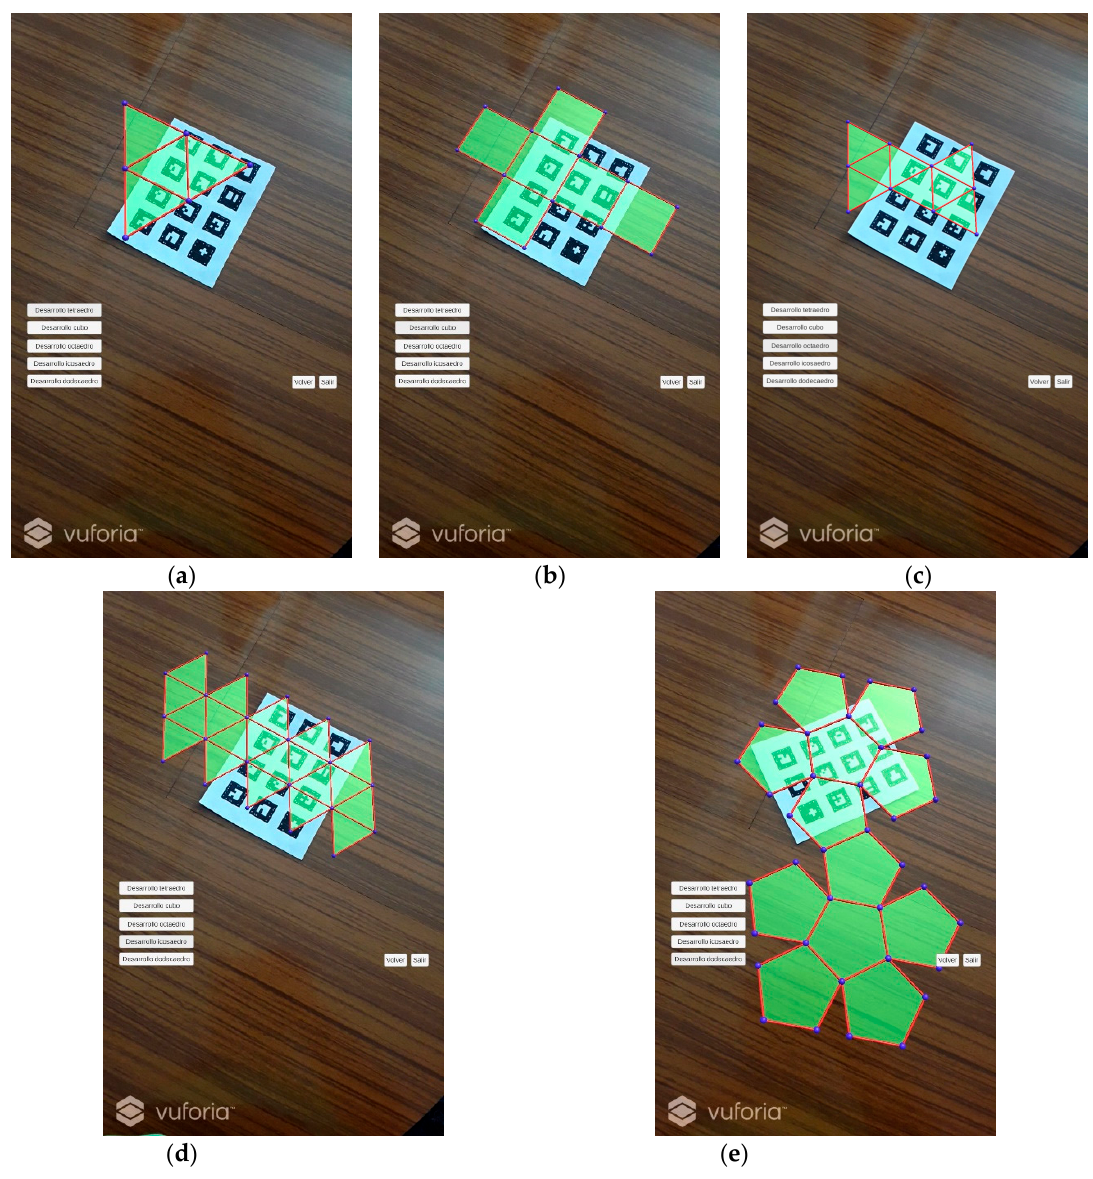
Figure 8. Images of flat developments of the platonic solids. ( a ) Tetrahedron; ( b ) Cube; ( c ) Octahedron; ( d ) Icosahedron; ( e ) Dodecahedron.